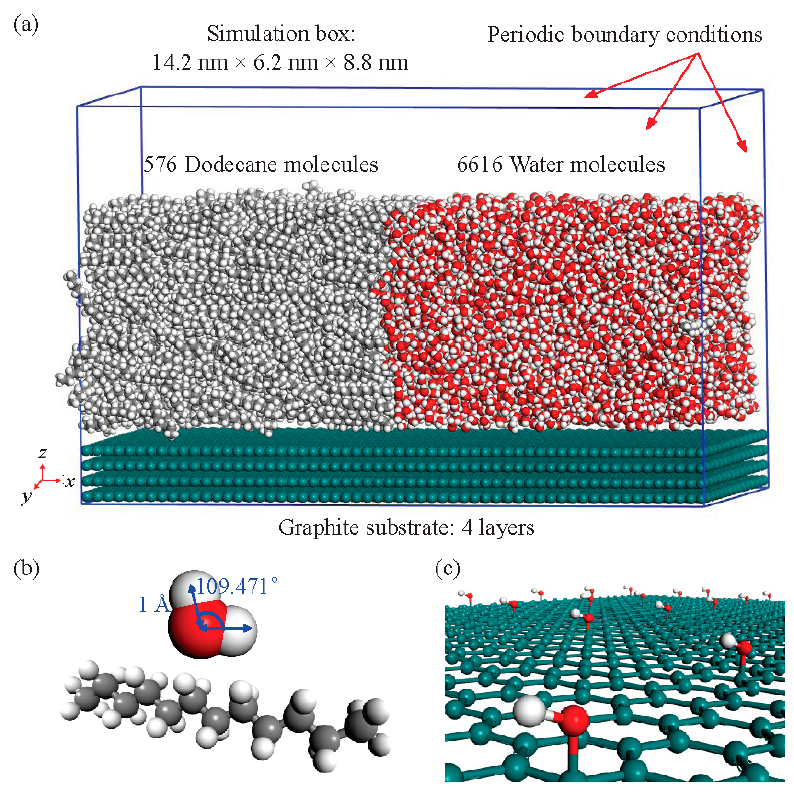
Figure 1. Oil-water-graphite system. ( a ) The final oil-water system (after 100 ps simulation in canonical (NVT) ensemble and 120 ps simulation in isothermal-isobaric (NPT) ensemble) on 4-layer graphite; ( b ) Structure of water and oil molecules; ( c ) Structure of hydroxyl-functionalized graphite surface.